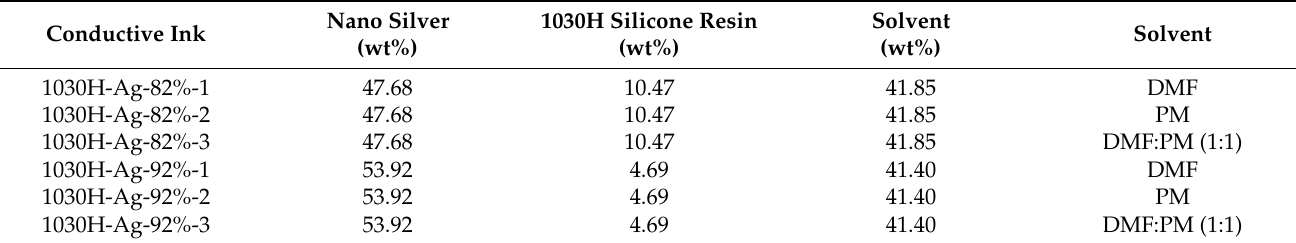
Table 2. Formulations of silver conductive inks with different solvent systems.